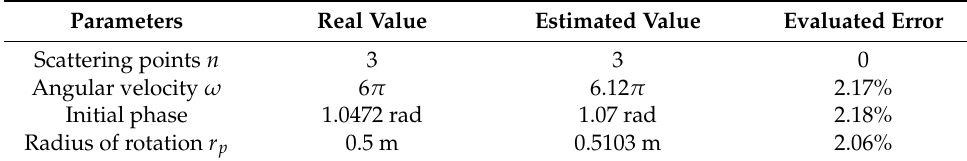
Table 2. Error analysis of parameter estimation results.